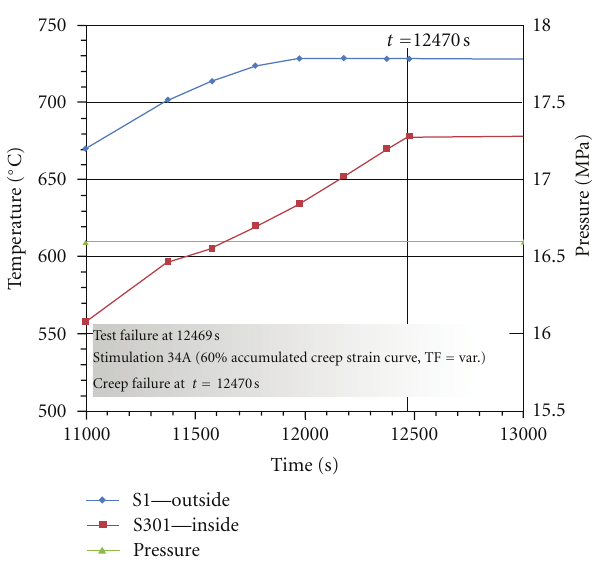
Figure 8: Loading conditions in the test pipe.